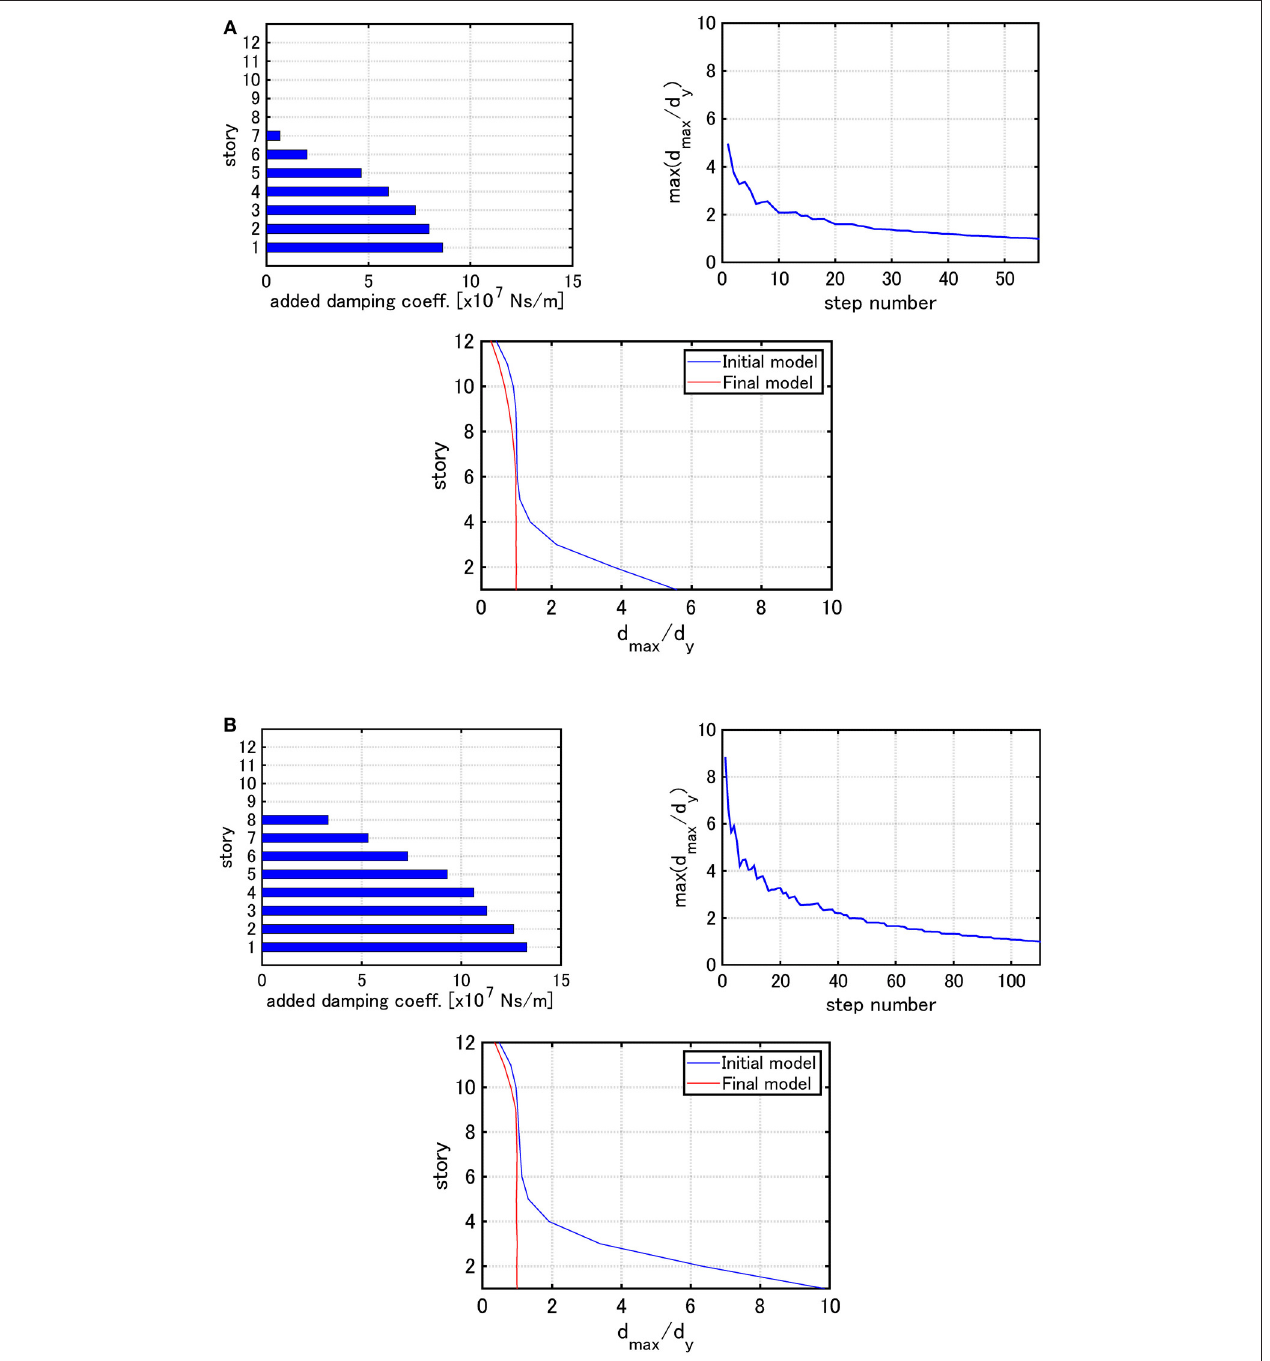
FIGURE 6 | Distribution of added damping coefficients, max ( d max , i / d y ) with respect to step number and the distribution of d max , i / d y under the critical double impulse for Model 1 (Problem 1): (A) V = 0.84[m/s], (B) V = 1.23[m/s]. Step 3 Find the story in which the largest reduction of f